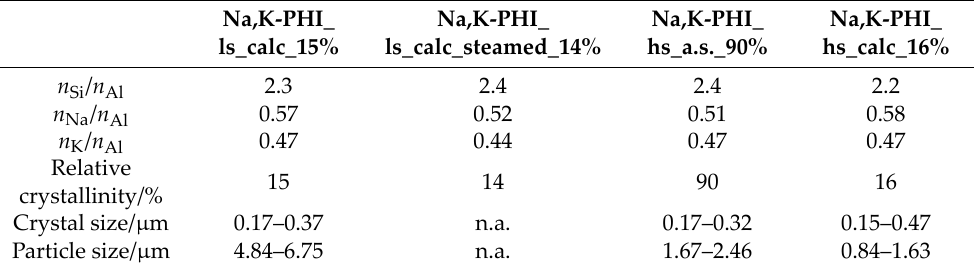
Table 2. Chemical composition of the catalysts before the reaction measured by ICP-OES, relative crystallinity calculated from the XRD data, crystal and particle sizes based on the SEM images.